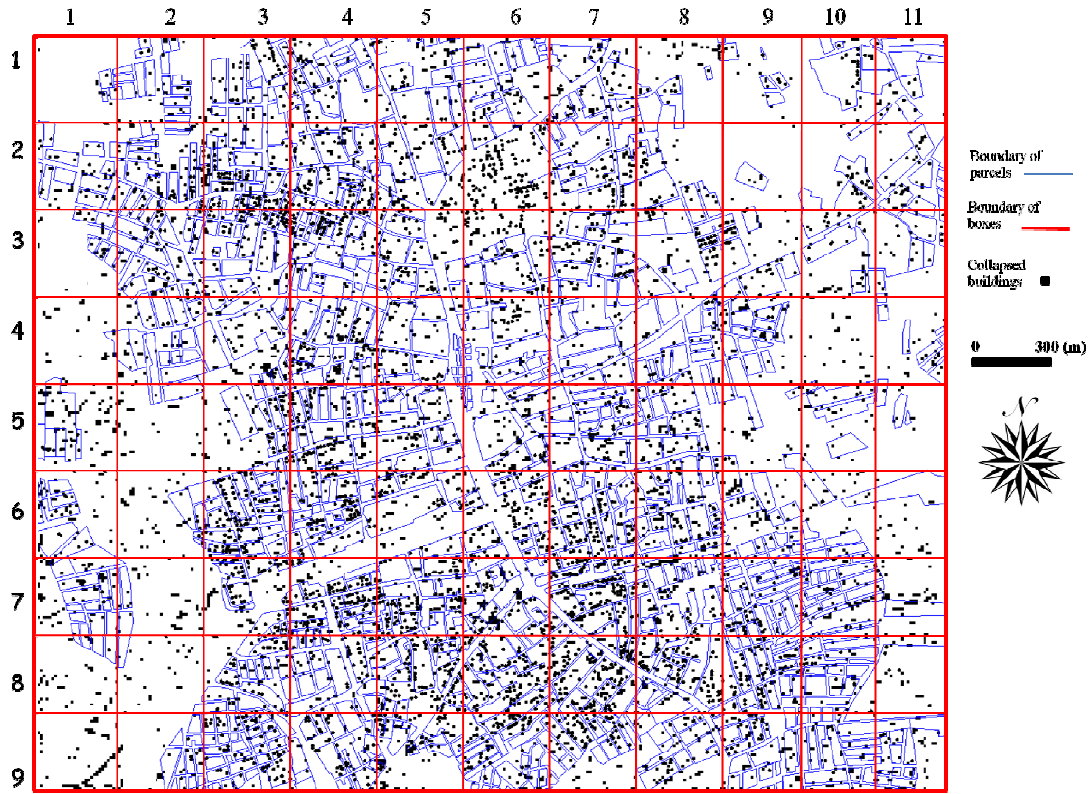
Figure 5. Blocks overlaid on the difference image (black: damaged areas, white: non- damaged